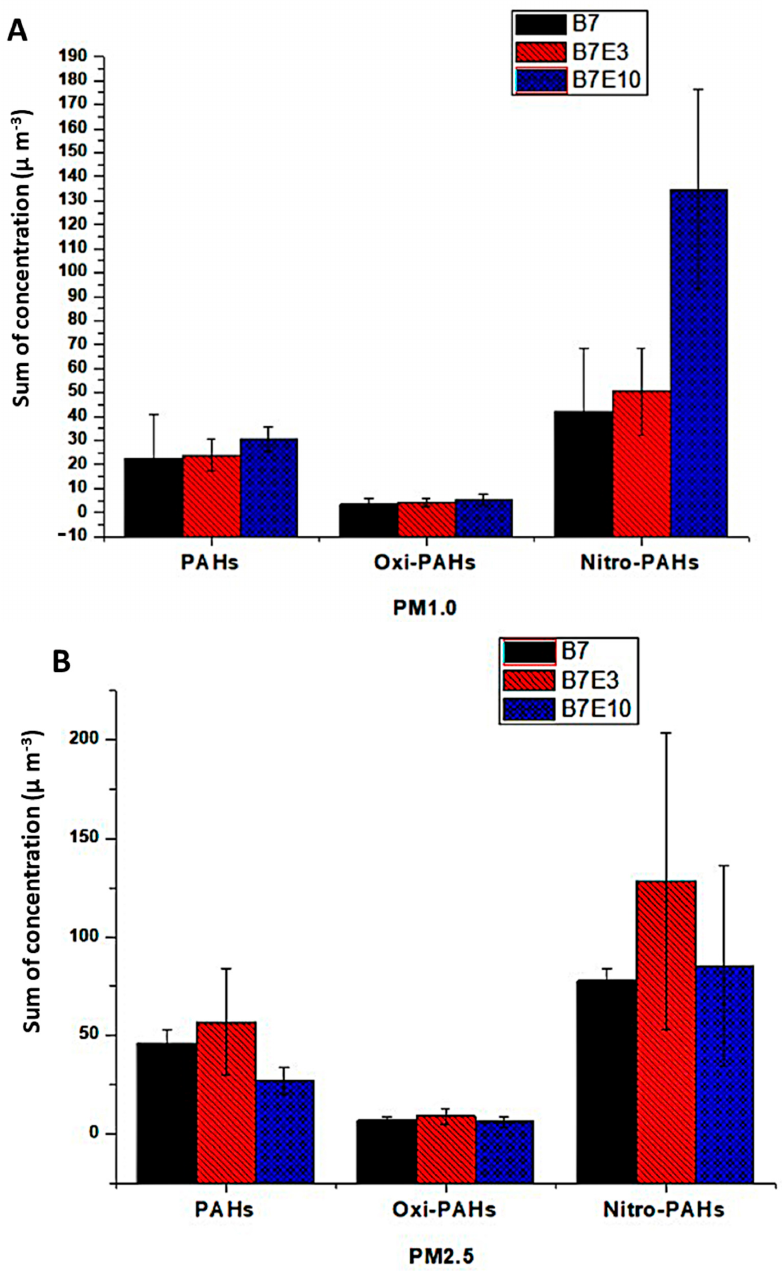
Figure 4. The total concentration of PAHs, quinones, and nitro-PAHs found in the particulate matter from B7, B7E3, and B7E10 blends. ( A ) PM 1.0 and ( B ) PM 2.5 . Biodiesel and alcohol are two of the most common types of alternative fuels used in diesel engines; however, their effects on the formation of PAHs, mainly nitro-PAHs and quinone derivatives, are not well known today. As far as it is known, our study has been the first to find PAHs and their nitro-PAHs and quinone derivatives in fine particles, such as PM 1.0 and PM 2.5, emitted from a diesel engine fueled with blends such as B7, B7E3, and B7E10, which brings more concern directly in relation to health-related outcomes than other studies that have considered only larger fractions of particulate matter. However, it is not so simple to compare these results in the literature since different models of engines, fuels, fuel blends, and working conditions have been used. 3.4. Emission Factors for PAH, Nitro-PAH, and Quinones in PM 1.0 and PM 2.5 From the PAH, nitro-PAH, and quinones were considered as diesel and biodiesel emission markers [24,37,68]; the EF for the major compounds was calculated and quanti- fied in PM1.0 and PM 2.5 samples: pyrene (PYR), fluoranthrene (FLT), phenanthrene (PHEN), naphthalene (NAPH), chrysene (CHRYS), nitrofluorene (2N-FLU), 2-nitrophe- nanthrene (2N-PHEN), 2-nitrobiphenyl (2-NBP), and 9,10-anthraquinones (9,10-AQ). The individual values and total EF of PAH, nitro-PAH, and quinones calculated for B7 with the addition of 3% and 10% anhydrous ethanol are reported in Table 5 for (a) PM 1.0 and (b) PM 2.5. Table 5. Emission Factors of concentrations of PAHs, nitro-PAHs, and quinones in ( a ) PM 1.0 and ( b ) PM 2.5.